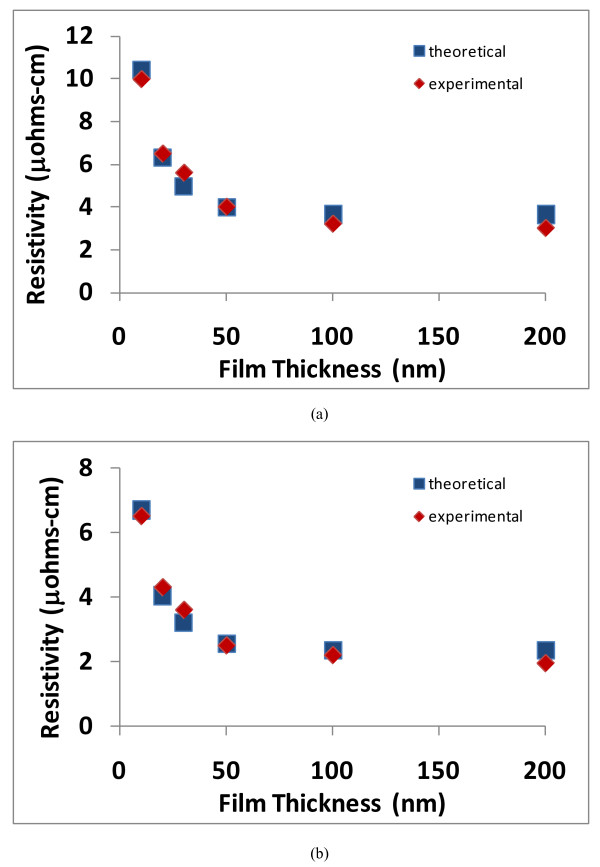
Comparison of theoretical and experimental resistivities for copper as a function of film thickness. The graphs in (a) and (b) represent copper films using different fabrication parameters (the experimental data is adapted from Rossnagel and Kuan [12]).